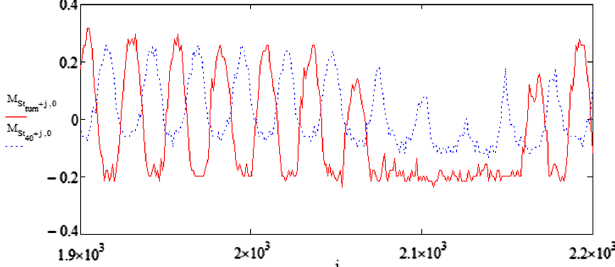
FIG. 5. Booster resistive wall monitor traces sampled every 1 ns (index j ) for the bunch beam current profiles right before (dashed blue) and 40 turns after (solid red) the extraction gap clearing.